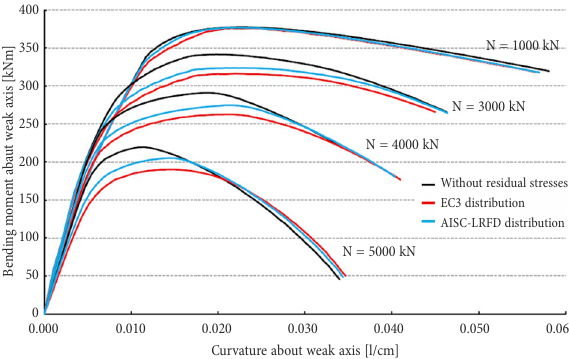
Fig. 11. Moment-curvature analysis for different values of compressive axial loads with and without residual stress effects: weak axis bending